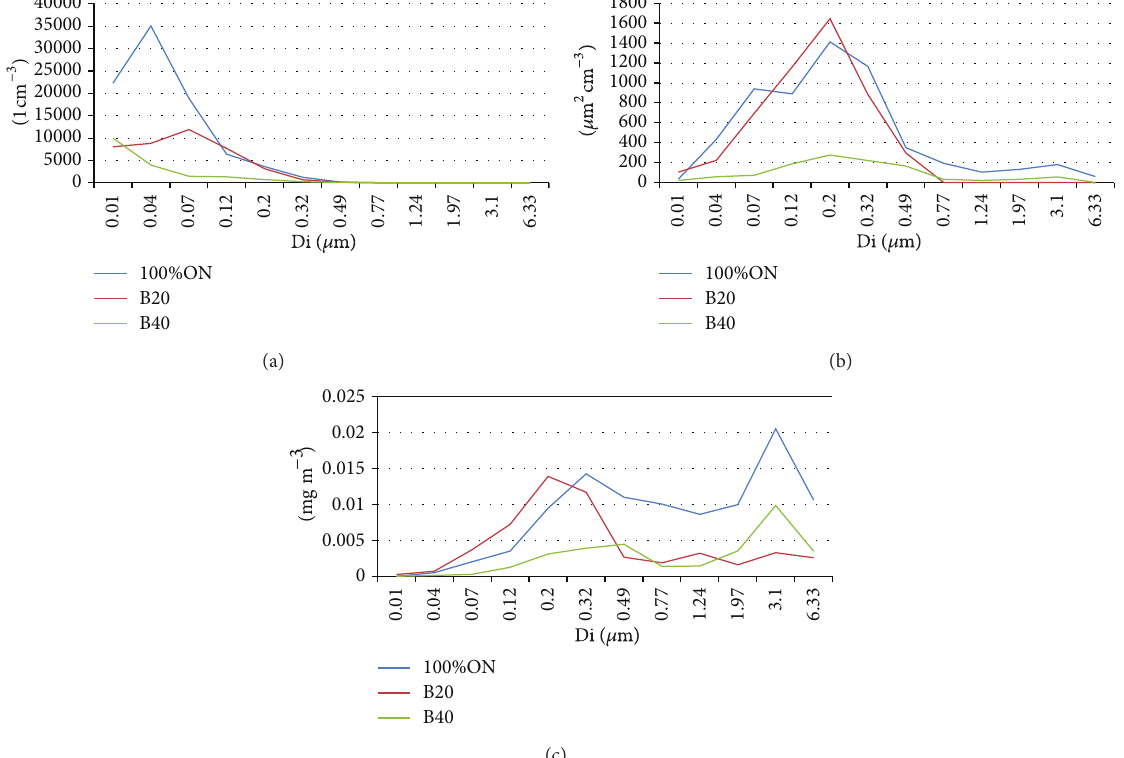
T 2: Average mass concentration of diesel engine exhaust gas particulates measured with ELPI.